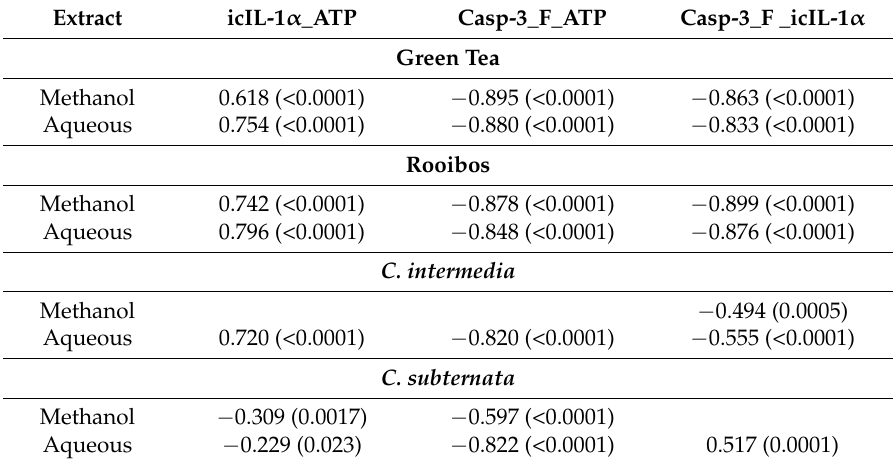
Table 5. Correlation among cell viability, caspase-3 activity (fold) and icIL1- α content as affected by green tea and herbal tea